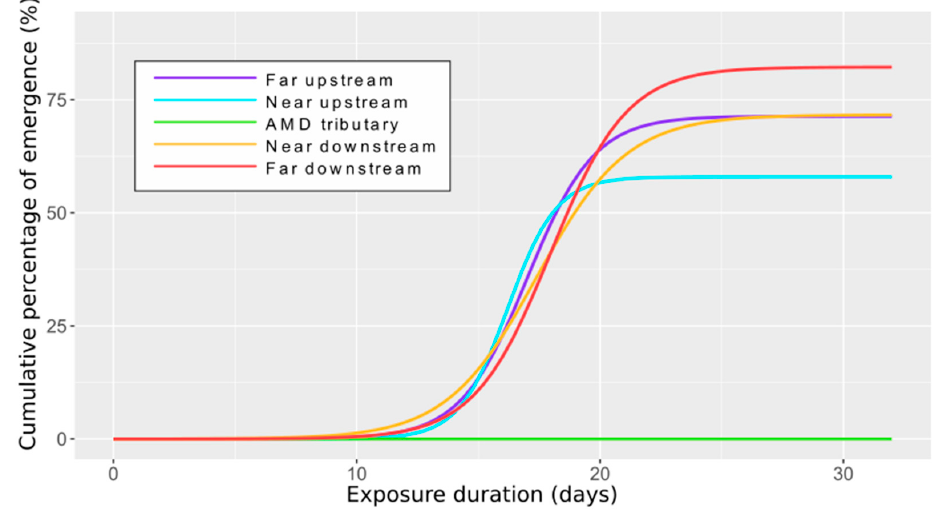
Figure 6. Time course of cumulative percentage of emergence of C. riparius encaged at the different stations.